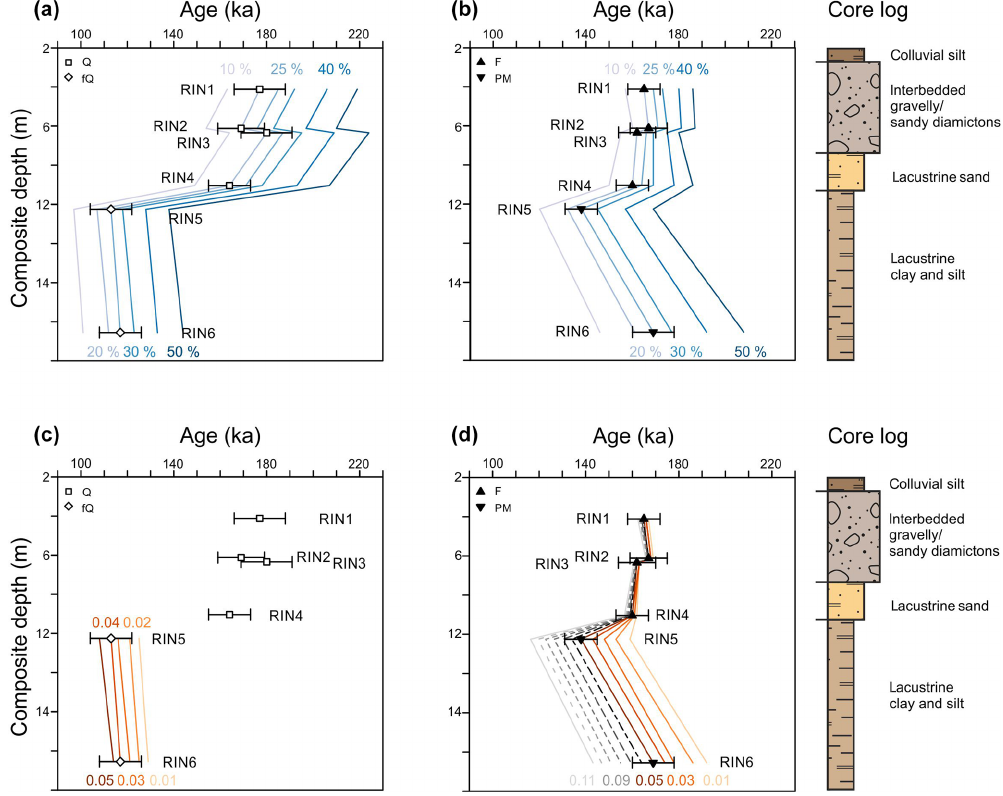
Figure 13. Ages of (a) Q and f Q and (b) F and PM (fading corrected following Kars et al., 2008) are shown for water contents between 10% and 50% and plotted against depth (line signature). (c) Ages of f Q are shown for alpha efficiency values between 0.01 and 0.05 and plotted against depth (line signature). No alpha component was considered for age determination of HF-etched Q, but accepted ages are presented for completeness. (d) F and PM (fading corrected following Kars et al., 2008) ages for alpha efficiency values between 0.01 and 0.11. Accepted ages are presented with 1 σ uncertainties as point signatures. The upper part of the core log is given on the right for comparison (see Fig. 2 for the full